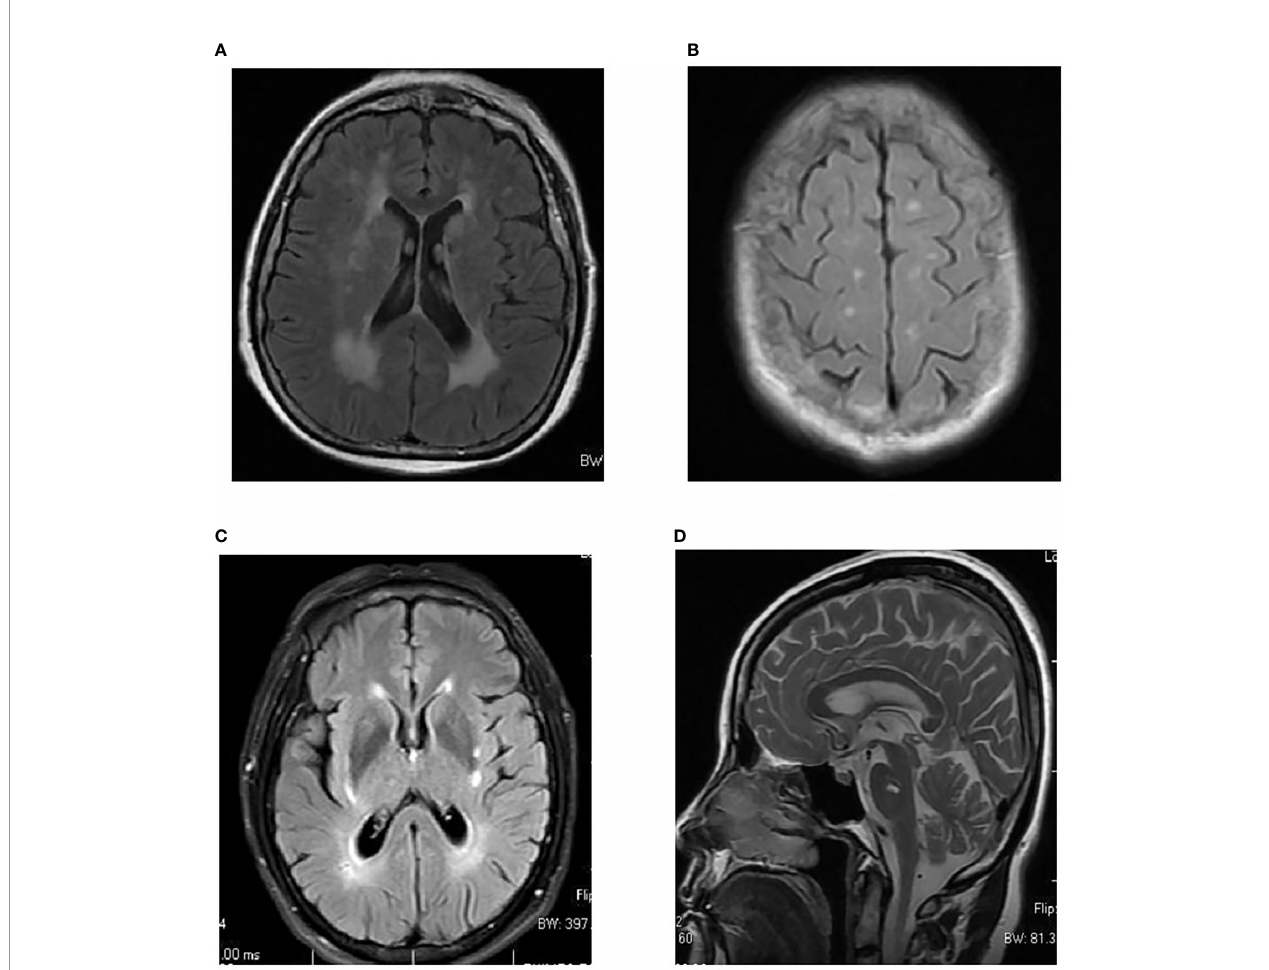
FIGURE 2 | Examples of topographical distribution of white matter lesions in MRI. (A) Periventricular white matter lesions (WMLs) (pvWMLs). (B) Subcortical WMLs (sWMLs). (C) Basal ganglia WMLs (bgWMLs). (D) Infratentorial WMLs